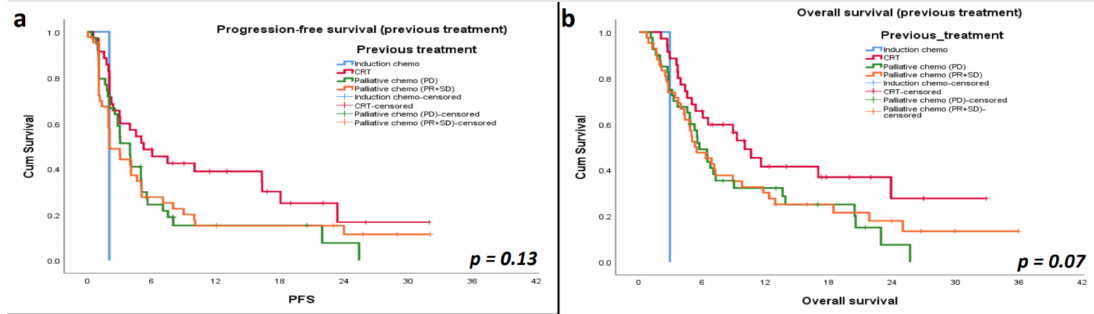
Figure A2. Kaplan–Meier curves for ( a ) progression-free survival and ( b ) overall survival in patients in the nivolumab group based on PD-L1